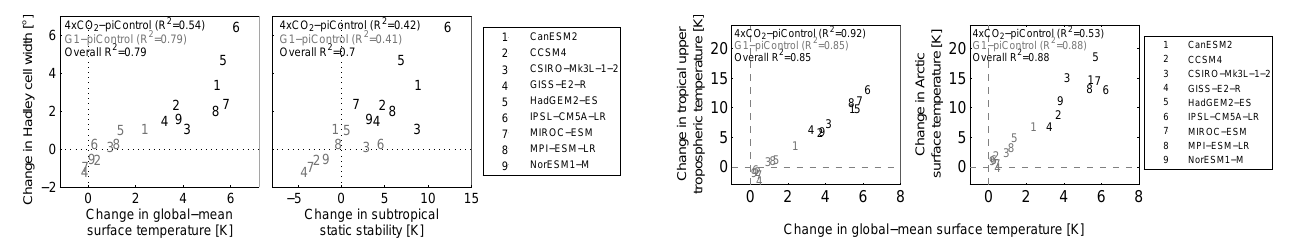
Figure 9. The change in the total Hadley cell width versus the change in global-mean surface temperature and the change in sub- tropical static stability. Positive changes in the Hadley cell width indicate tropical expansion. Shown are values for the 4 × CO 2 ex- periment minus the piControl experiment (black) and for the G1 experiment minus the piControl experiment (gray). The percent of the inter-model variation in the change in the Hadley cell edge lat- itude explained by the change in global-mean surface temperature and the change in subtropical static stability between each experi- ment is indicated in each plot.